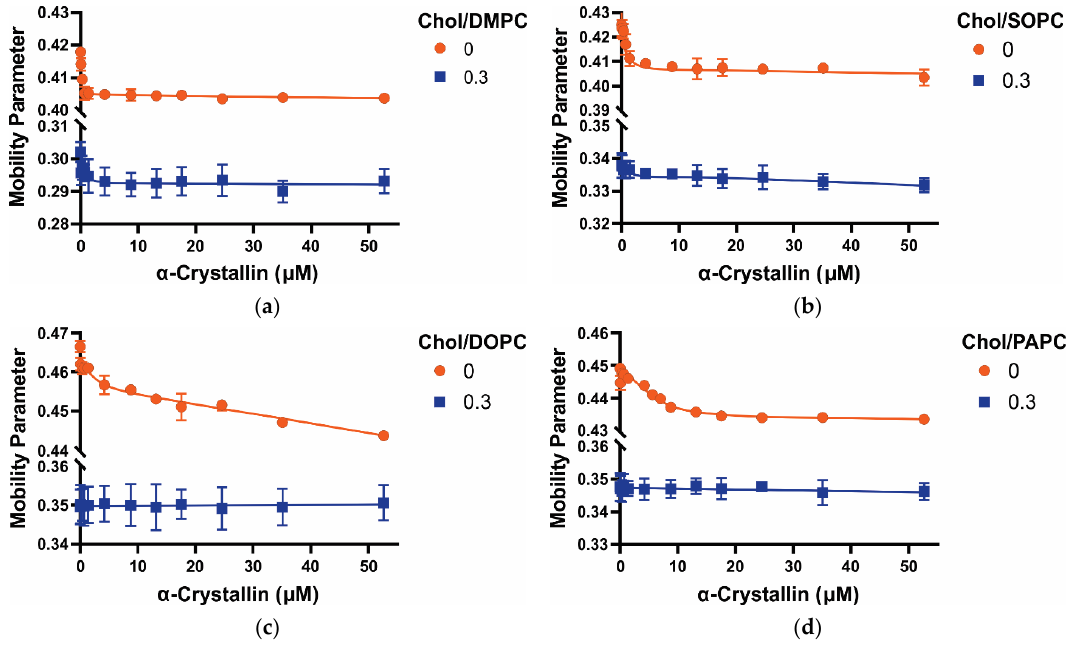
Figure 4. ( a – d ) Show the profiles of the mobility parameter (h + /h 0 ) plotted as a function of α -crystal- lin concentration for Chol/DMPC , Chol/SOPC, Chol/DOPC, and Chol/PAPC membranes, respec- tively, at Chol and PL mixing ratios of 0 and 0.3. Our previous studies [45–47] explain a detailed method to calculate the mobility parameter (h + /h 0 ). The data points are expressed as mean ± stand- ard deviation from three independent experiments, and the solid lines serve as the visual guides. The mobility parameters are different for different PC membranes, showing that the mobility near the headgroup regions of membranes depends on the acyl chain length and degree of unsaturation of membranes. For all Chol-free membranes, the mobility parameter decreases with an increase in α -crystallin concentration, representing that these membranes become more immobilized near the headgroup region with the α -crystallin association. The addition of Chol decreases the mobility pa- rameter of membranes, representing that these membranes regions near the headgroup become more immobilized with increased Chol content. However, the decrease in mobility parameter with increased α -crystallin concentration is less pronounced with the addition of Chol in the membranes, showing that Chol inhibits α -crystallin-membrane association. With increased α -crystallin concen- tration, mobility parameters of Chol/DMPC and Chol/DOPC membranes decrease, unlike for the Chol/DOPC and Chol/PAPC membranes, further showing that the acyl chain length and degree of unsaturation strongly modulate the mobility near the headgroup regions of membranes.